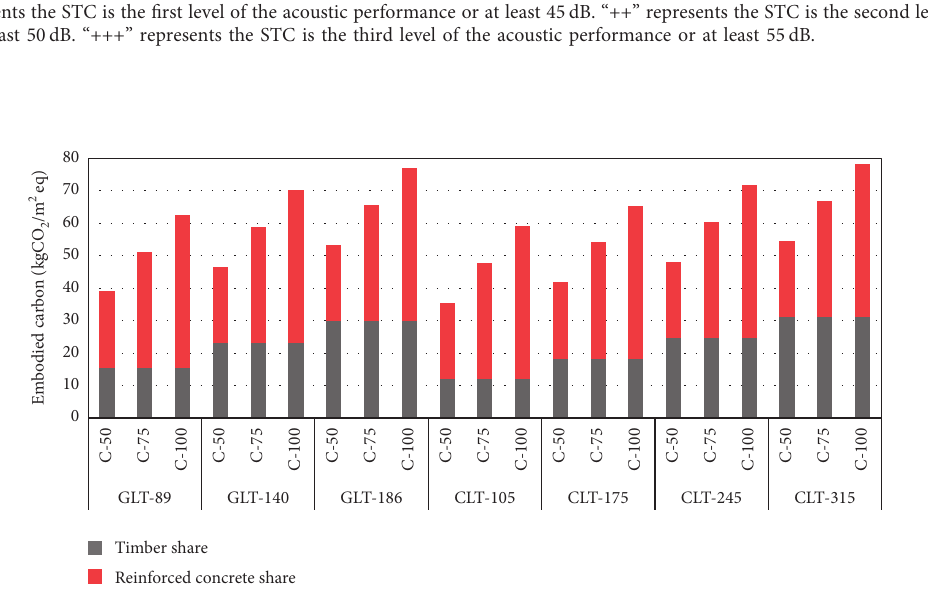
Figure 6: Embodied carbon versus thickness of concrete and MTP in TCC